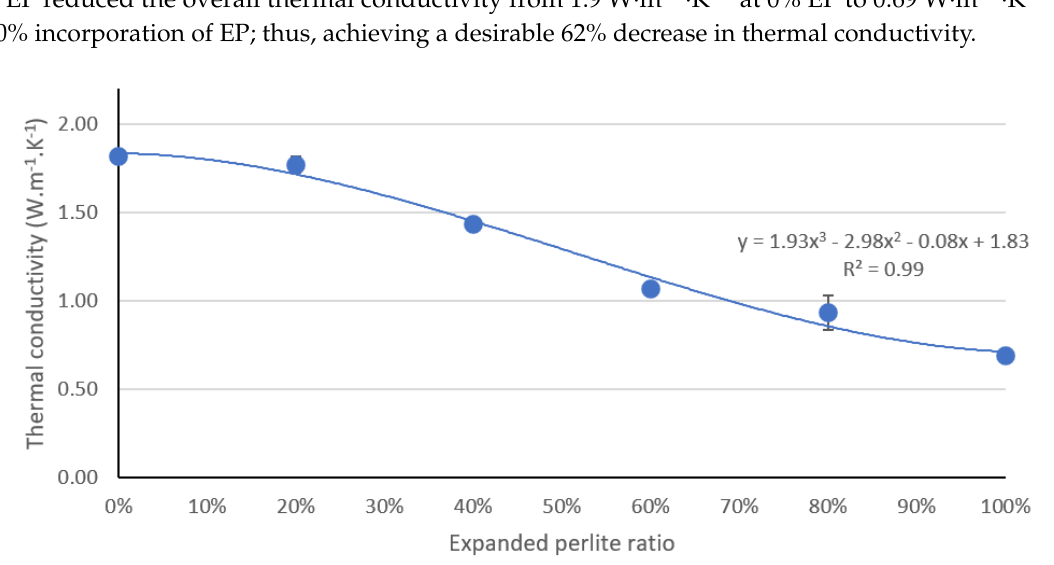
ff ect of EP aggregate on the thermal conductivity of the Figure 8. Effect of EP aggregate on the thermal conductivity of the concrete. Figure 8. E Figure 8. Effect of EP aggregate on the thermal conductivity of the concrete.